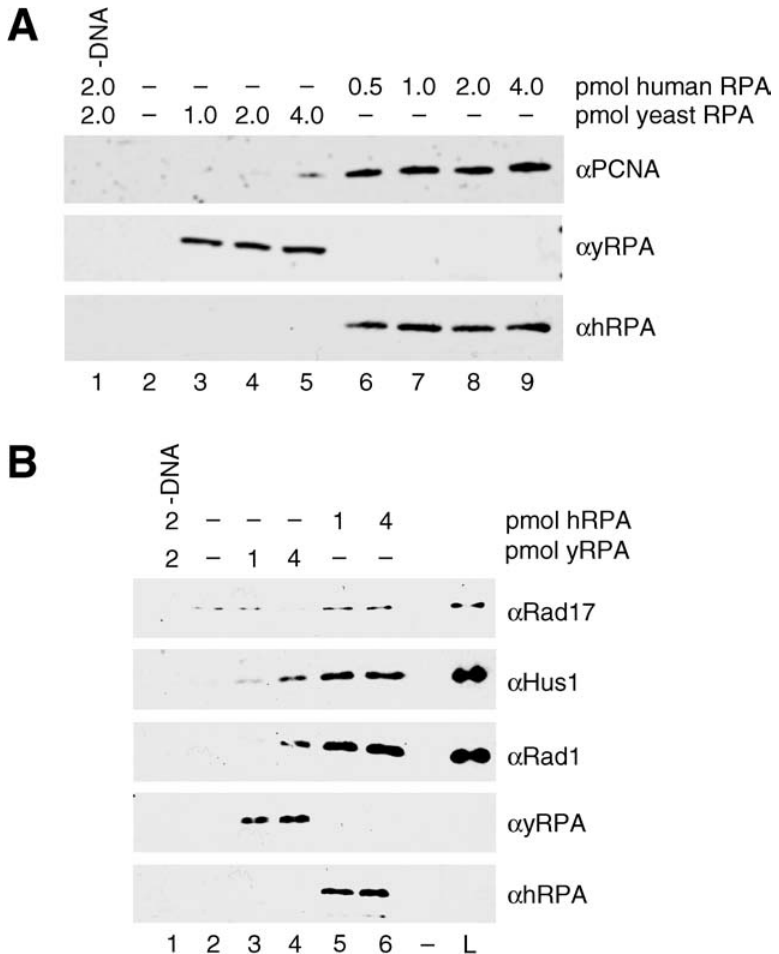
Figure 6. PCNA and RHR Loading Are Specifically Stimulated by Human RPA In both (A) and (B), lanes represent loading reactions performed as described in the Materials and Methods with either 5 9 recessed or 3 9 recessed primer–template DNA–RPA complex bound to beads, and recovery of proteins with the beads was analyzed by Wb for the indicated proteins. In (A), PCNA loading was assayed in the absence of RPA (lane 2) or in the presence of the indicated amounts of either yeast RPA (lanes 3–5) or human RPA (lanes 6–9). All reactions contained 3 9 recessed primer–template DNA (except for that in lane 1), 2 pmol of PCNA, 0.25 pmol of RFC, and ATP. In (B), RHR loading was assayed in the absence of RPA (lane 2) or in the presence of the indicated amounts of either yeast RPA (lanes 3 and 4) or human RPA (lanes 5 and 6). All reactions contained 5 9 recessed primer–template DNA (except for that in lane 1), 1 pmol of RHR complex, 0.25 pmol of RSR, and ATP. DOI: